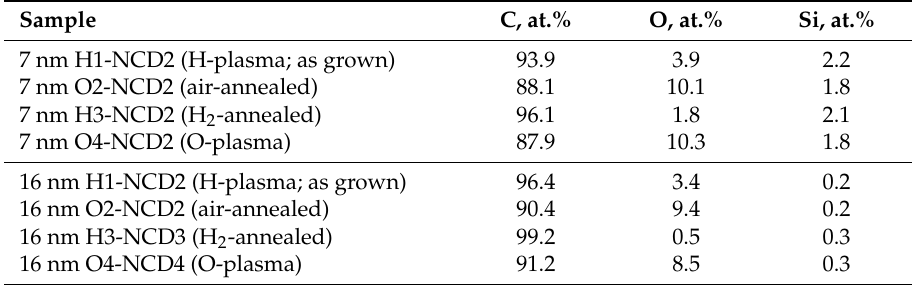
Table 1. Relative atomic concentration of chemical elements of the 7 and 16 nm NCD2 before and after hydrogenation by annealing in hydrogen gas at 700 ◦ C for 6 h calculated from XPS spectra.